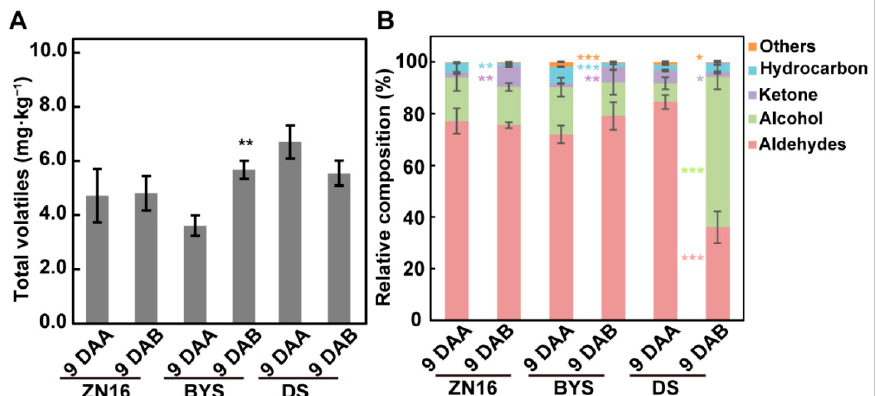
Figure 4. Total volatile analysis in cucumber fruits after darkening treatment. The data set for volatile analysis is given in Supplementary Table S1. Total volatile content ( A ) and composition ( B ) in cucumber fruits after bagging treatment were analyzed by ANOVA followed by Tukey’s test (* P < 0.05, ** P < 0.01, *** P < 0.001), and bars represent means ± standard deviations ( n = 3). Values are means of three independent biological replicates.